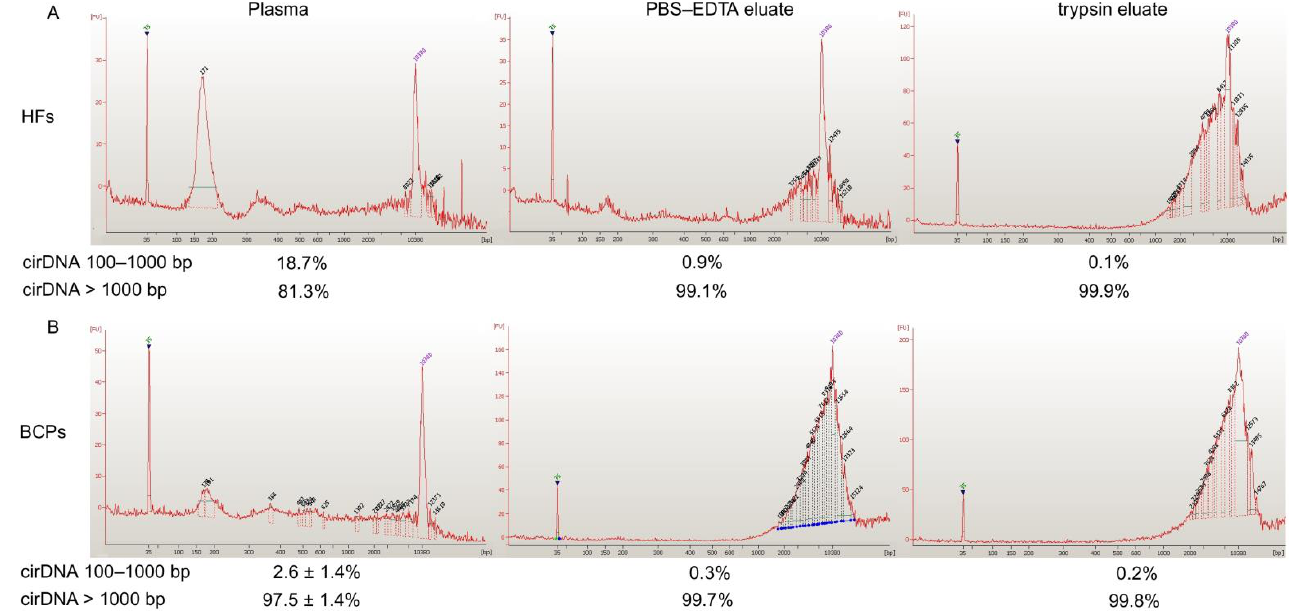
Figure 2. Size distribution of DNA circulating in the blood of HFs ( A ) and BCPs ( B ). Data of Agilent